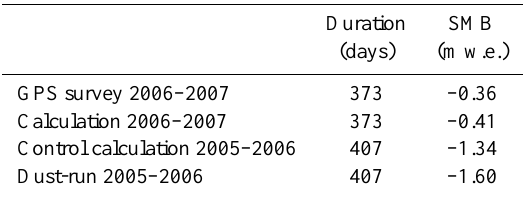
Table 4. Specific mass balances (SMB) calculated for the Gregoriev